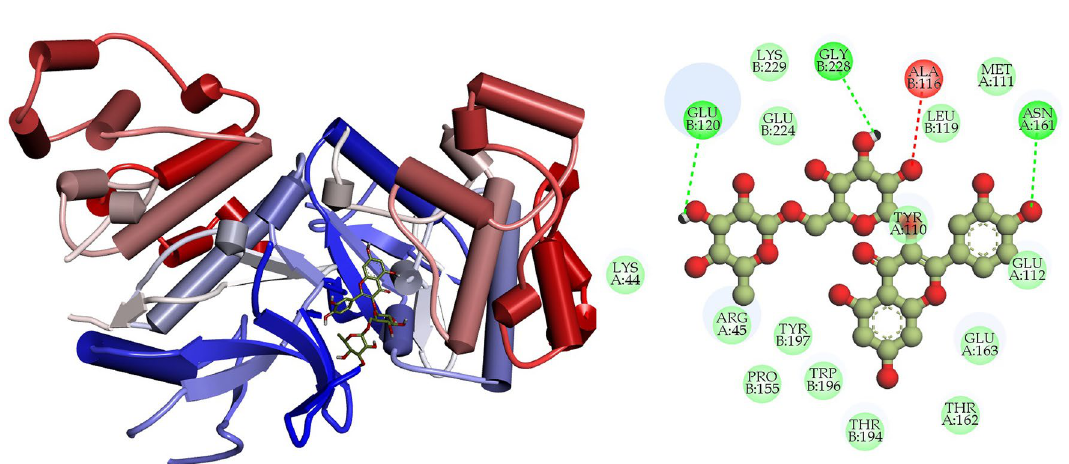
Figure 5. Depicted the interaction between the compound CID: 442428 (Naringin) and MAPK6. Left side representing 3D and the right side representing 2D complex protein–ligand interaction.